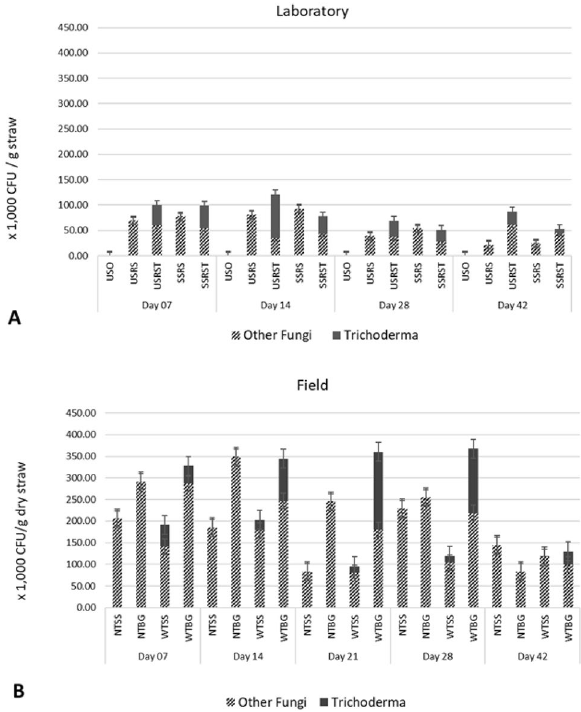
Figure 2. Fungal population dynamics in the ( A ) laboratory and ( B ) field incubation experiments. USO = unsterile soil only; USRS = unsterile soil plus rice straw; USRST = unsterile soil plus rice straw plus Trichoderma ; SSRS = sterile soil plus rice straw; SSRST = sterile soil plus rice straw plus Trichoderma ; NTSS = no Trichoderma on soil surface; NTBG = no Trichoderma below ground; WTSS = with Trichoderma on soil surface; WTBG= with Trichoderma below